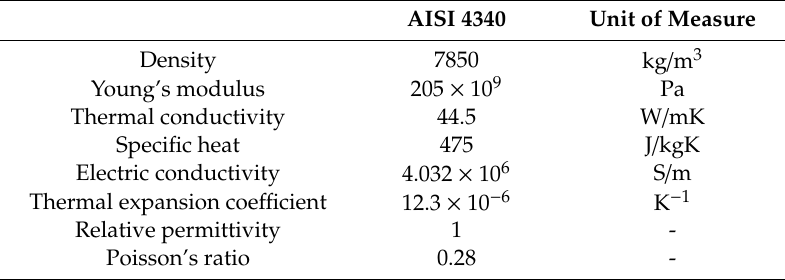
Table 4. Stainless-steel AISI 4340 properties.